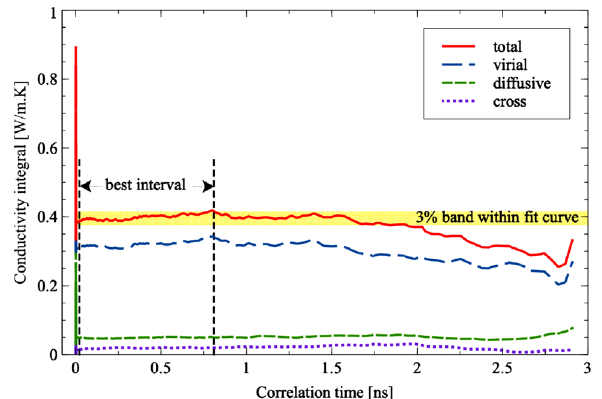
Figure 3. Heat-flux autocorrelation integral curve for virial, diffusive and the total conductivity. The 3% band around the plateau value is highlighted, and the corresponding best interval (Eq. 12) is shown. The average thermal conductivity is then measured over this best interval, and all contributions to the conductivity here use the same interval, ensuring that the sum of the components (in this case, virial and diffusive conduction) add up to the total.